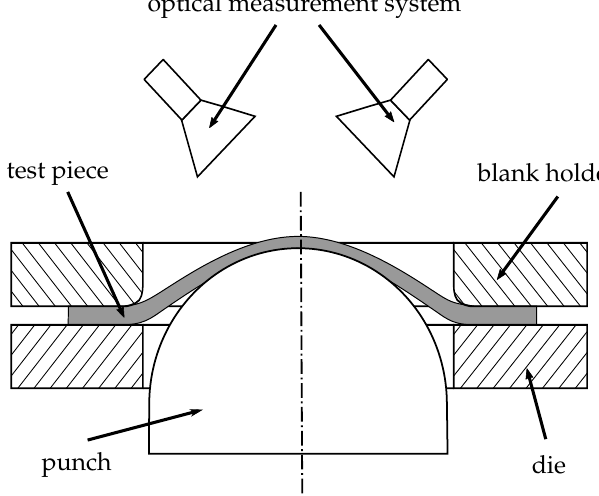
Figure 1. Schematic of the Nakajima experimental setup.